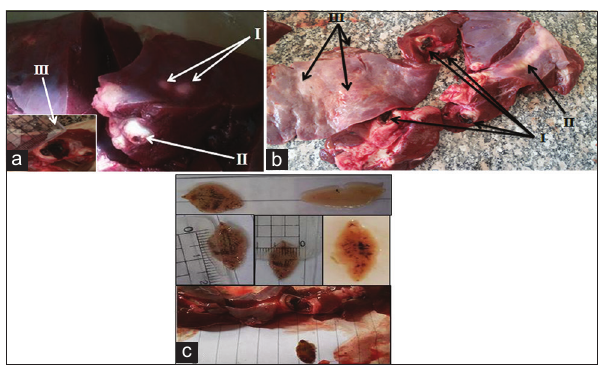
Figure-2: Macroscopic liver fascioliasis detected from cattle, and bovine carcasses in examined cattle and buffaloes slaughtered at the municipal abattoir of El-Kharga. (a) I - Varies large sizes (1.5-2.7 cm) fascioliasis tunnels observed on intact external liver surfaces, II - Liver postmortem slicing showing fibrosis fascioliasis tunnels, and III - Cut section of fascioliasis tunnels, its sizes about (1.5 cm) observed infected liver. (b) I - Several liver fascioliasis tunnels oozing grassy blackish hemorrhagic exudate varies sizes (0.5-1.5 cm), II - Fascioliasis tunnels observed on intact external liver surfaces, and III - Liver postmortem slicing showing fibrosis fascioliasis tunnels. (c) Macroscopic leaf-like Fasciola spp